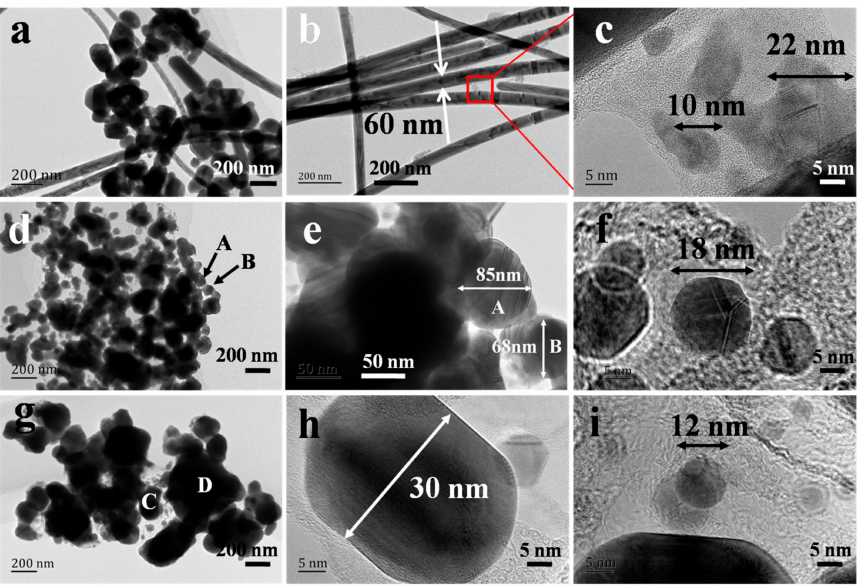
Figure 4. TEM images of AgNW samples for 10 min growth time with NaCl ( a – c ), NaBr ( d – f ) and NaCl/NaBr ( g – i )